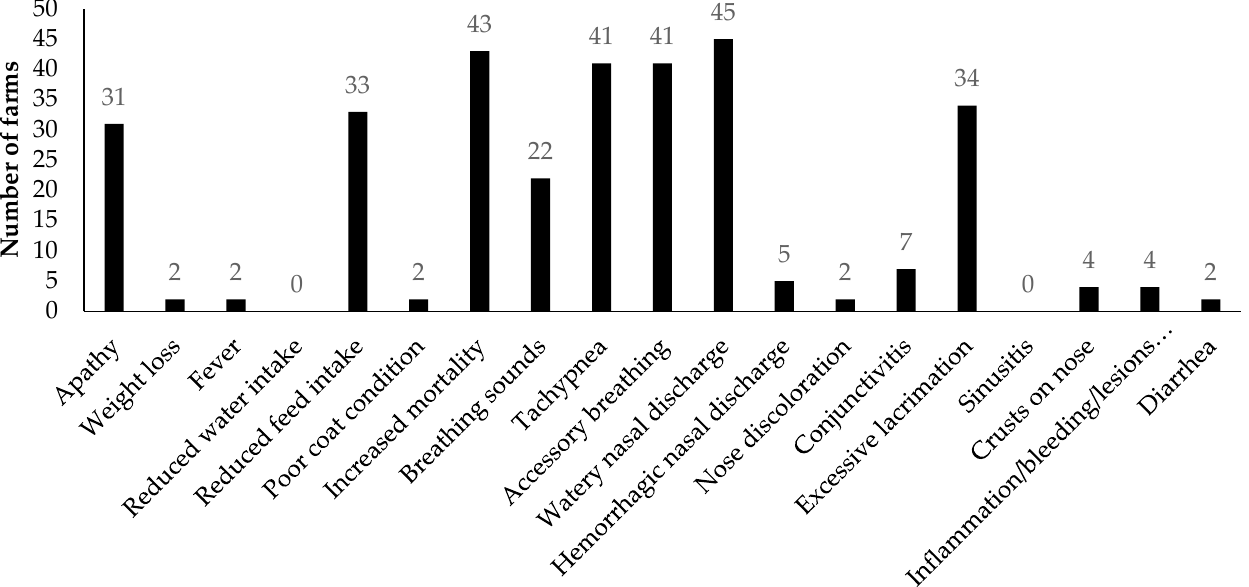
Figure 1. Overview showing per clinical sign, of the 19 different clinical signs of the standardized list (Table S1), the number of farms ( n = 62) for which the sign was observed in kits, male or female adult minks. Note that inflammation/bleeding/lesions refer to these on the gingiva.